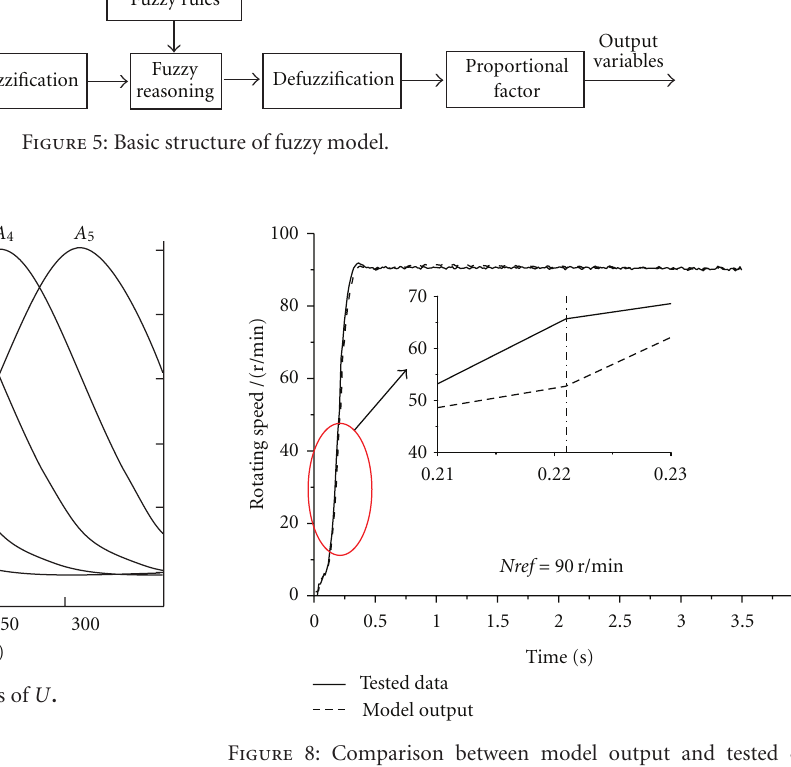
Figure 8: Comparison between model output and tested data ( Nre f = 90 r/min).